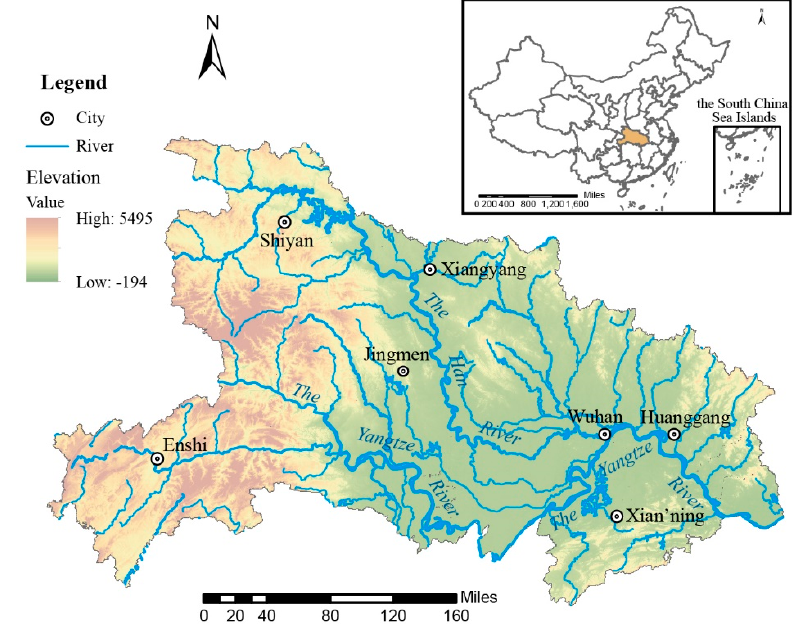
Figure 1. Location map of the study area.